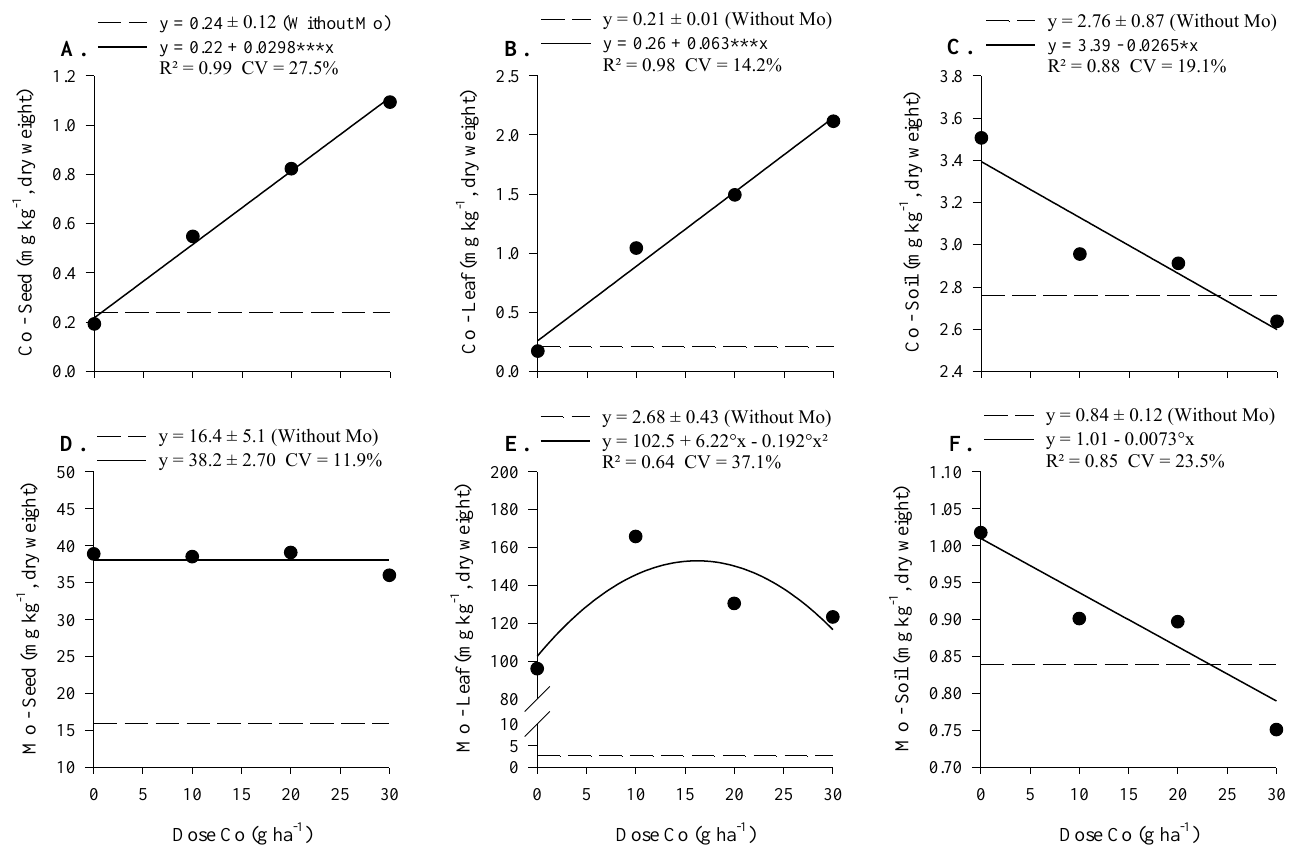
Figure 3. Cobalt and Mo concentration in seed ( A , D ), in diagnosis leaf of soybean ( B , E ), and soil ( C , F ) as a function of Co doses and Mo applied to parent plants via foliar in the maturation phase, under field conditions. °, *, and *** — Significant at 10, 5, and 0.1% probability by t -test. The concentrations of Ca, Mg, S, Fe, Mn, Zn, and Cu in soybean seed were statistically different when treated with Co and Mo (Table 4). Overall, the application: (i) of Co (10 – 30/800 g ha −1 of Co and Mo) decreased the concentration of Ca and Mn; (ii) of Mo (0 – 30/800 g ha −1 of Co and Mo) decreased the concentration of Fe; and (iii) of the highest dose of Co (30/800 g ha −1 of Co and Mo) provided a reduction in the concentration of Mg, S, Zn, and Cu, compared to the control. There was no statistical difference between the control and the treatments for the nutrient concentration in the diagnostic soybean leaf, except for B, where the application of only Mo (0/800 g ha −1 of Co and Mo) increased the concentration of B. The application of Co provided a linear reduction of 14, 12, 15, 14, 13, and 29% of the concentration of Ca, Mg, S, Cu, Mn, and Zn in the seeds and a linear reduction of 21 and 24% of the concentration of B and Mn in the diagnostic leaf of soybean, respectively. Table 4. Macro and micronutrient concentration in soybean seeds and shoots as a function of foliar Co and Mo doses applied to parent plants foliarly in the maturation phase, under field conditions.